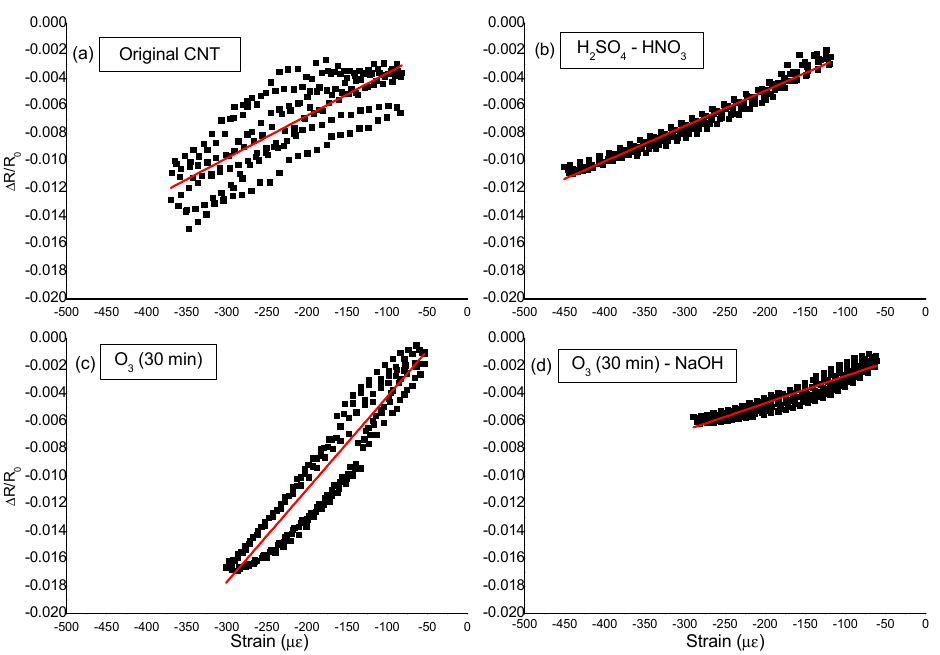
Figure 7. Correlation between the resistance fractional change and the strain for cement pastes with 1% of CNT subjected to different oxidation treatments: ( a ) original CNT; ( b ) CNT-HNO 3 -H 2 SO 4 ); ( c ) CNT-O 3 (30 min); ( d ) O 3 (30 min)-NaOH. 180 day-old specimens, with a 1mA DC current, 200 N/s